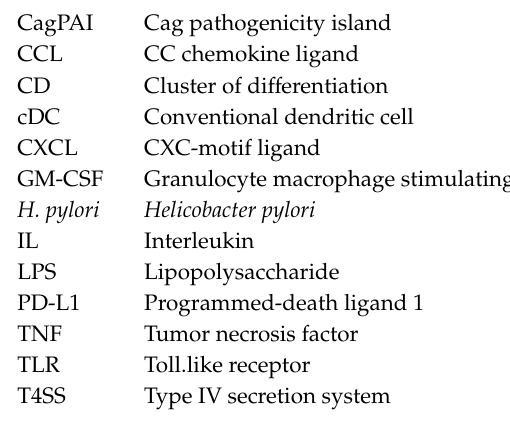
Figure S1: No changes in the phenotype of moDCs infected with H. pylori wt or a mutant lacking the T4SS after 24 h. Figure S2: In the absence of H. pylori infection, TLR blocking does not a ff ect the cDC2 phenotype. Figure S3: E ff ects of TLR10 blocking on H. pylori -induced cytokine and chemokine secretion by cDC2s. Figure S4: E ff ects of TLR4 blocking on H. pylori -induced cytokine and chemokine secretion by cDC2s. Figure S5: E ff ects of TLR2 blocking on H. pylori -induced cytokine and chemokine secretion by